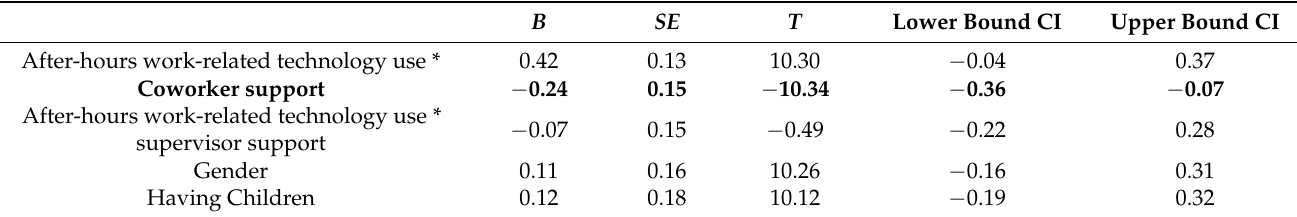
Table 4. Moderation Model results for coworker support.